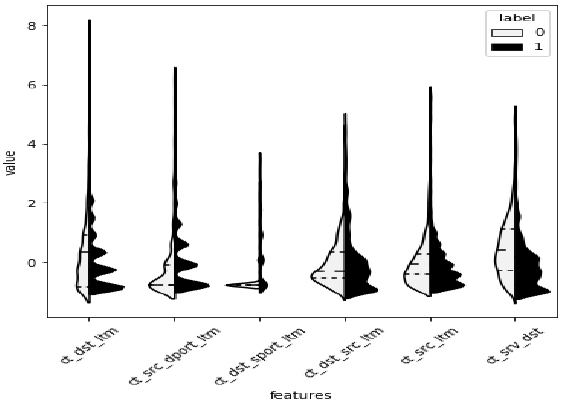
Fig 3. Violin plots for six significant features of the dataset